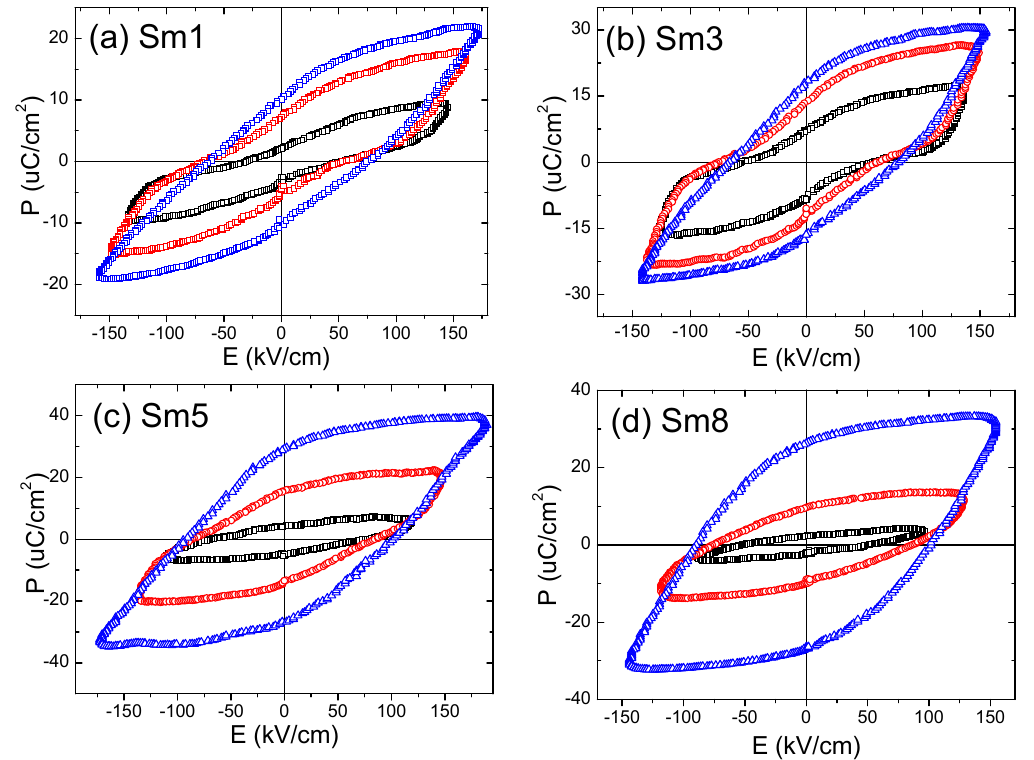
Figure 8. The ferroelectric P–E hysteresis loops of the ( a ) Sm1, ( b ) Sm3, ( c ) Sm5, and ( d ) Sm8 samples under different electrical fields. These samples were all sintered at 825 °C and post-annealed at 300 °C.